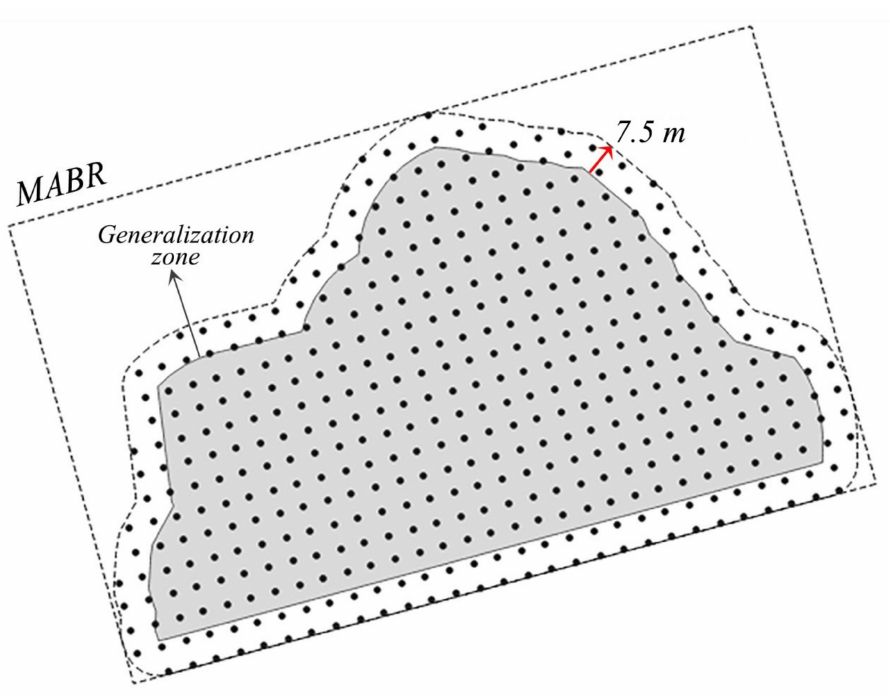
Figure 5. Grid point set of a generalization